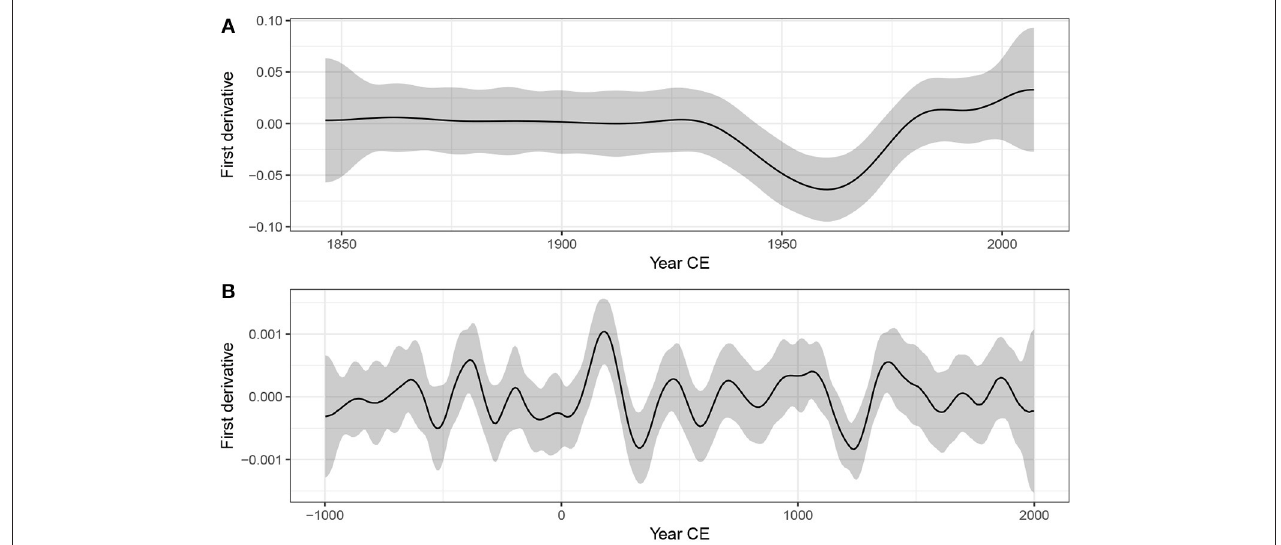
FIGURE 10 | Estimated first derivatives (black lines) and 95% simultaneous confidence intervals of the GAM trends fitted to the Small Water δ 15 N (A) and Braya-Sø U K 37 (B) time series. Where the simultaneous interval does not include 0, the models detect significant temporal change in the response.